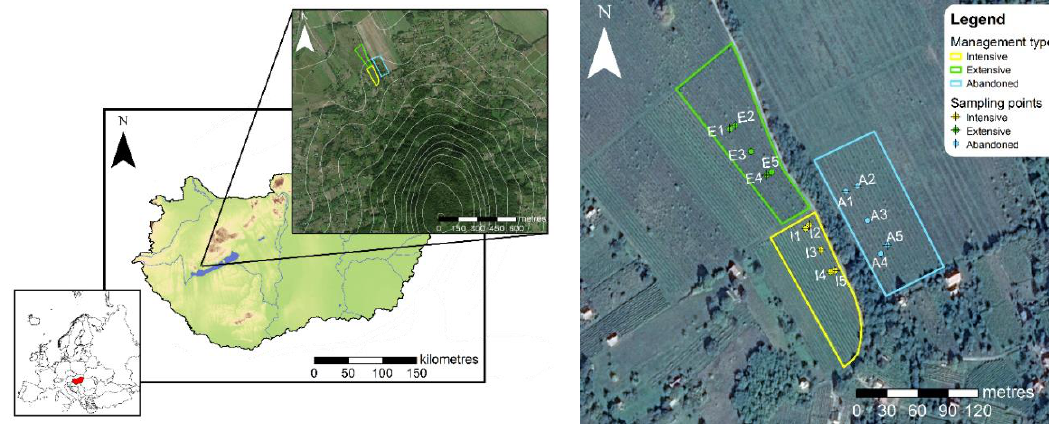
Figure 1. The location of the sampled vineyards (I: intensive; E: extensive; A: abandoned; 1–5: Figure1. sampling points).